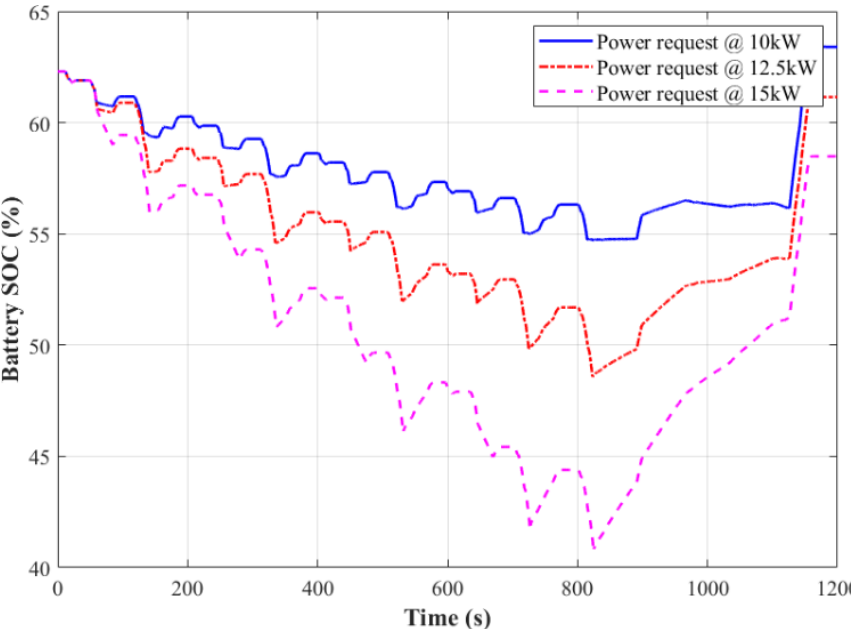
Energies 2022 , 15 , x FOR PEER REVIEW Figure 7. Evolution of battery SOC at different power requests. Figure 7. Evolution of battery SOC at different power requests.